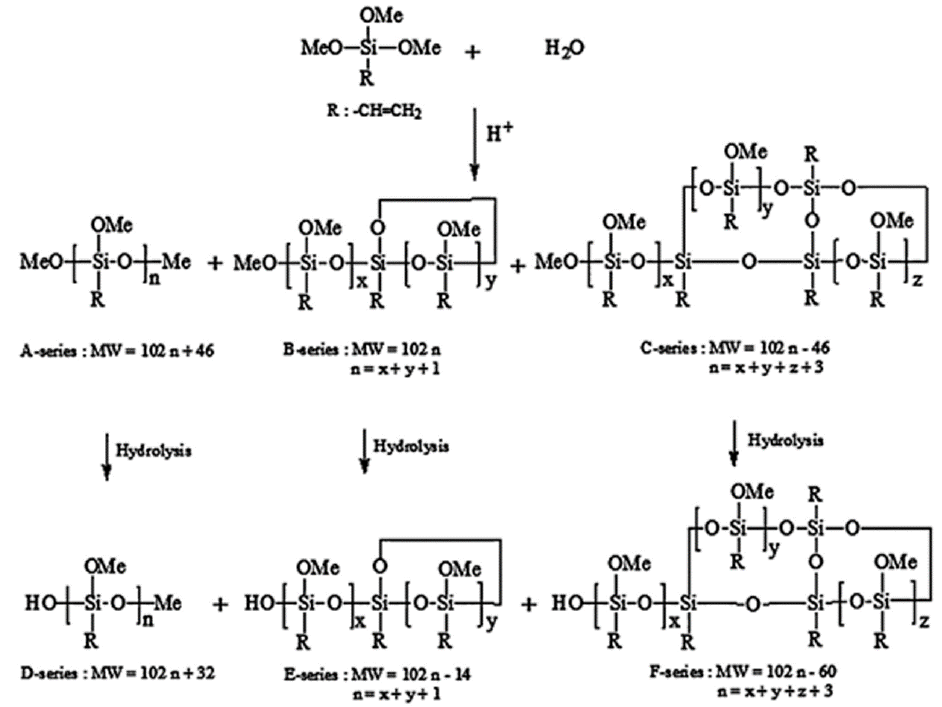
Figure 18. Schematic diagram to show the oligomerization steps. Reprinted with permission from [58]. Copyright Elsevier, 2015.